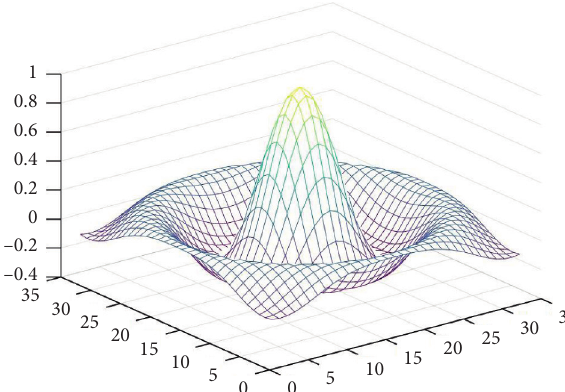
Figure 5: The conclusion expression of logistic regression analysis model